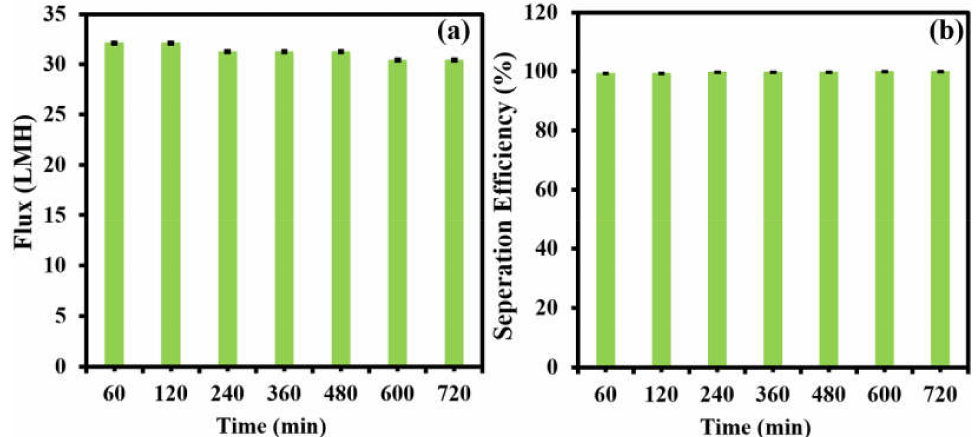
Figure 10. Long-term monitoring of ( a ) flux and ( b ) separation efficiency at 1 bar using oil/water emulsions at 125 ppm using an M-100 membrane.